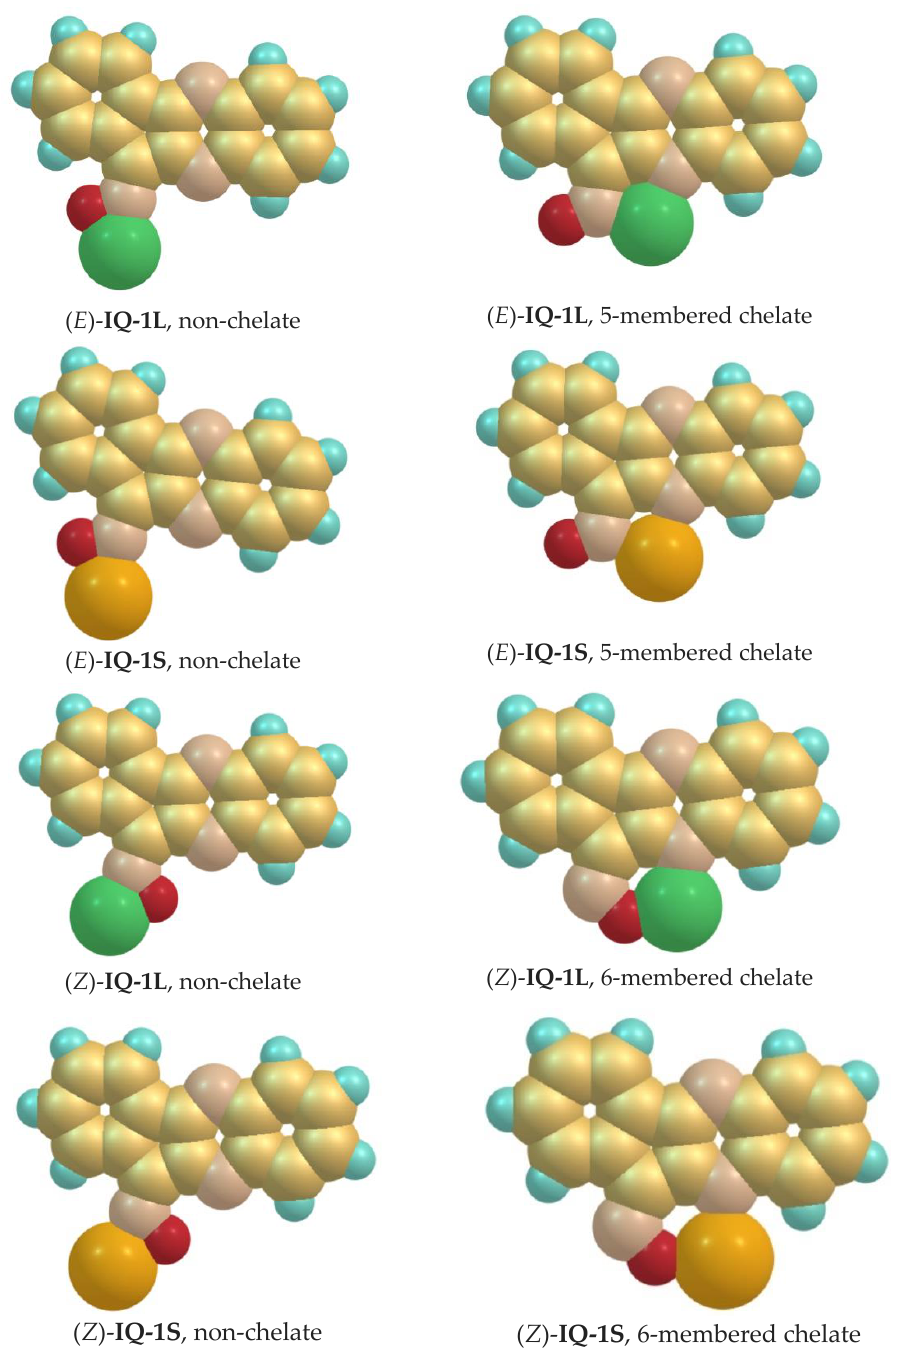
Figure 1. Low-energy geometric structures of the Na + and Li + salts of IQ-1 in non-chelated and chelated forms of their E and Z isomers.